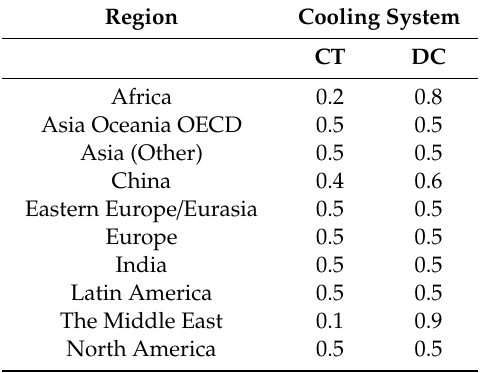
Table 3. Future share of cooling technologies by region, in the case of increased electricity generation by